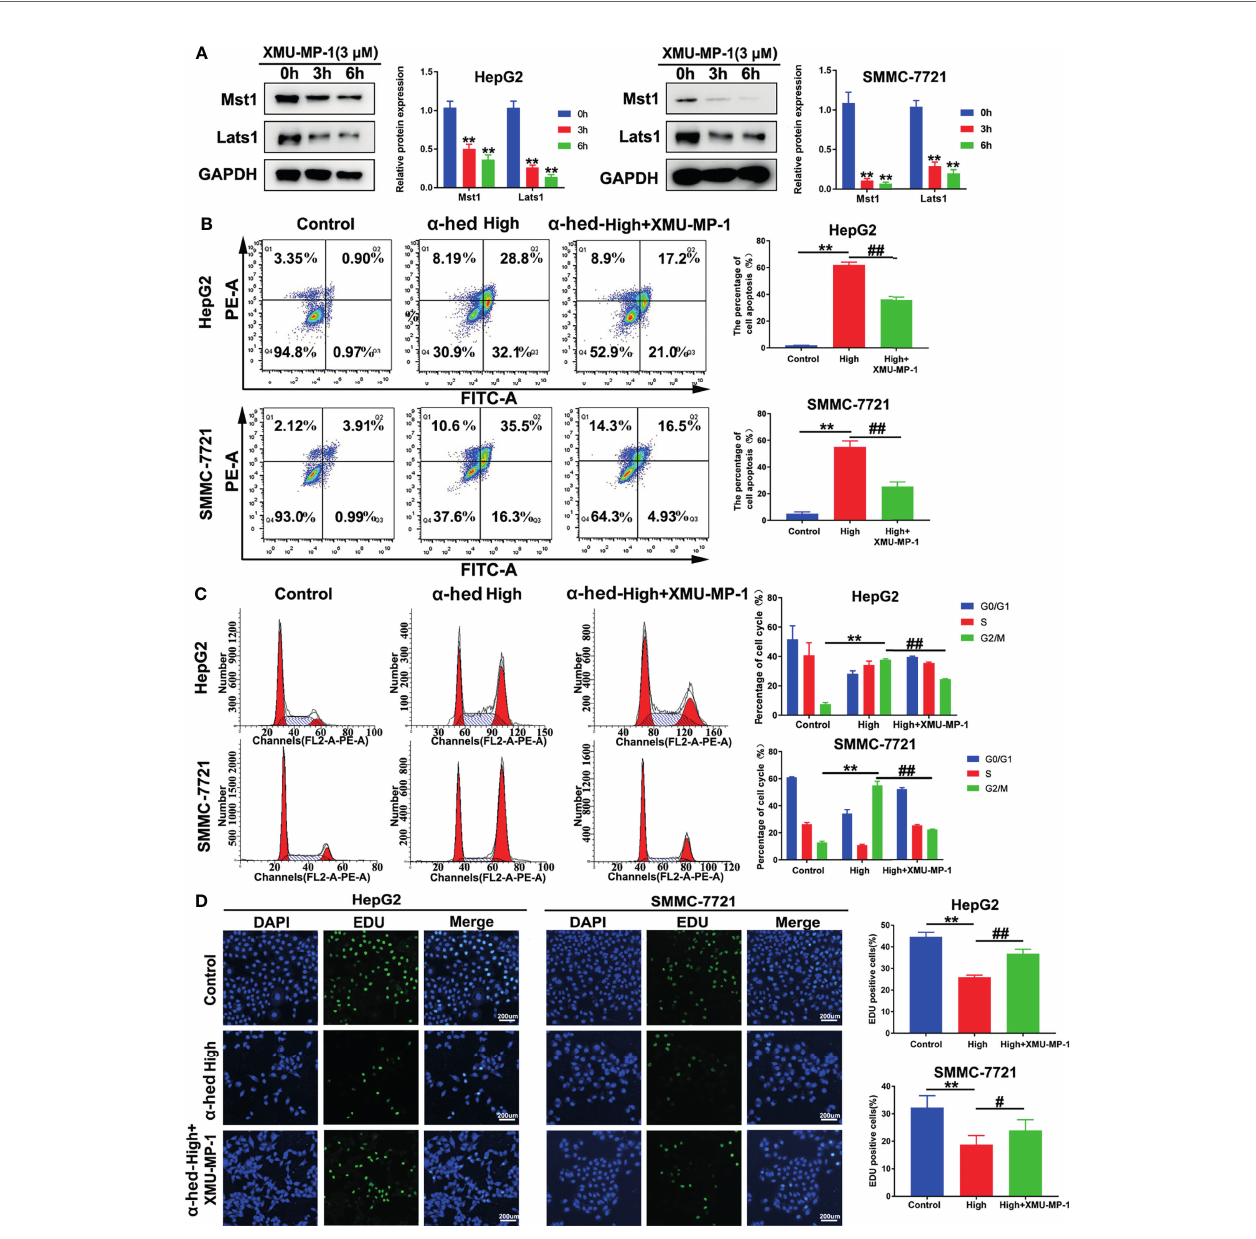
FIGURE 4 | Inhibition of Mst1 activation reversed the effect of a -hederin on hepatoma cell proliferation. (A) Western blot analysis of Mst1 and Lats1 expression in HepG2 and SMMC-7721 cells treated with XMU-MP-1 for 3 h or 6 h. (B) Flow cytometric analysis of apoptotic HepG2 and SMMC-7721 cells after a -hederin or a -hederin/XMU-MP-1 treatment. (C) Flow cytometric analysis of G1- and G2/M-phase subpopulations in HepG2 and SMMC-7721 cells treated with a -hederin or a -hederin/XMU-MP-1. (D) Cell proliferation assay using EDU labeling in HepG2 and SMMC-7721 cells treated with a -hederin or a -hederin/XMU-MP-1. Signi fi cance: ** p < 0.01 versus control, #p<0.05 versus High concentration, ## p < 0.01 versus High